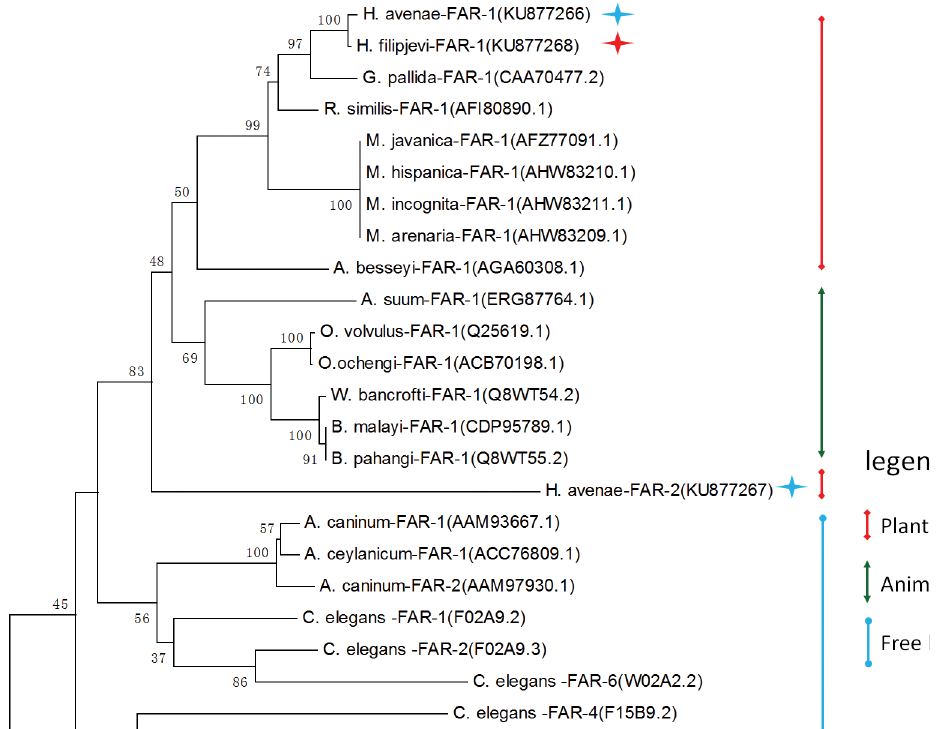
Fig 2. Phylogenetic tree containing FAR proteins of nematodes. A neighbor-joining phylogenetic tree with protein sequences of Ha-FAR-1, Ha-FAR-2, Hf-FAR-1 (marked with asterisks) and the 24 amino acid sequences of FAR proteins from free-living, animal-parasitic and plant-parasitic nematodes. The phylogenetic tree was constructed by Mega 6.0 after aligning the protein sequences with ClustalW. The percentage bootstrap values were inferred from 1,000 replicates and are indicated at the nodes. Scale bar represents 0.2 amino acid substitutions per